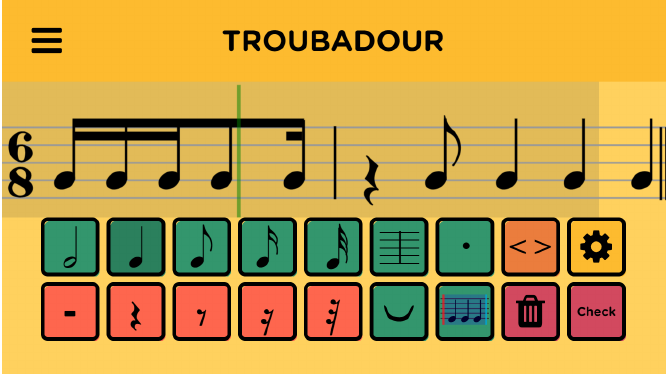
Figure 2. The landscape screen orientation layout of the rhythmic dictation application on a mobile device. The input keyboard is re-arranged to aid user experience in this